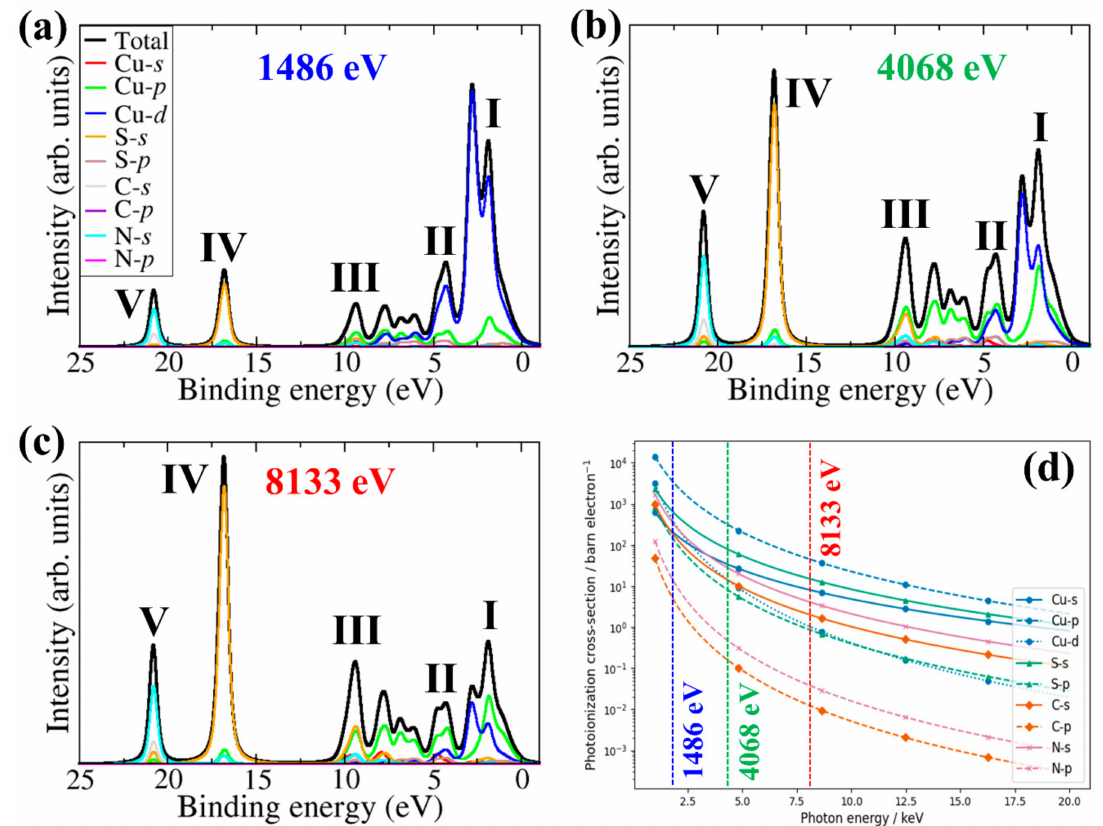
Figure 3. DFT-simulated XPS valence band spectra of hexagonal β -CuSCN obtained at ( a ) 1.486 keV (Al K α 1 ), ( b ) 4.068 keV, and ( c ) 8.133 keV ionizing photon energy. The dependence of the photoionisation cross-section on the ionising photon energy for the atomic orbitals is shown in ( d